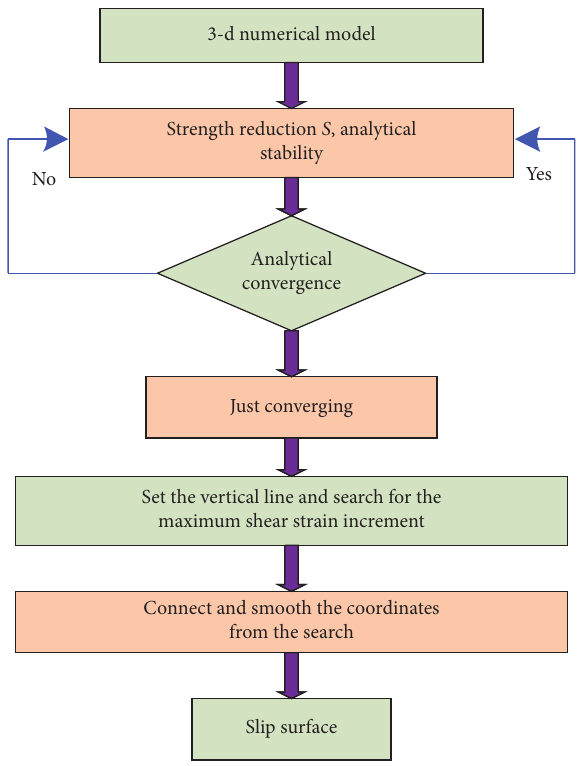
Figure 8: Flowchart of slip plane